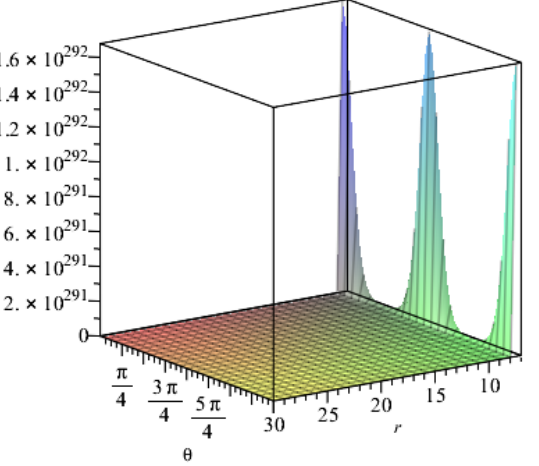
Figure 9. Relationship between the resistance value of the embedded carbon fibre and the thickness of the tunnel.